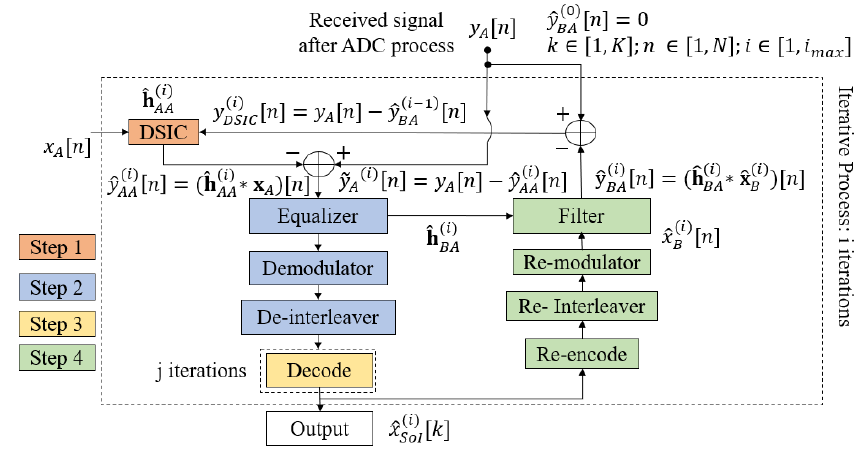
Figure 6. Joint iterative blind algorithm